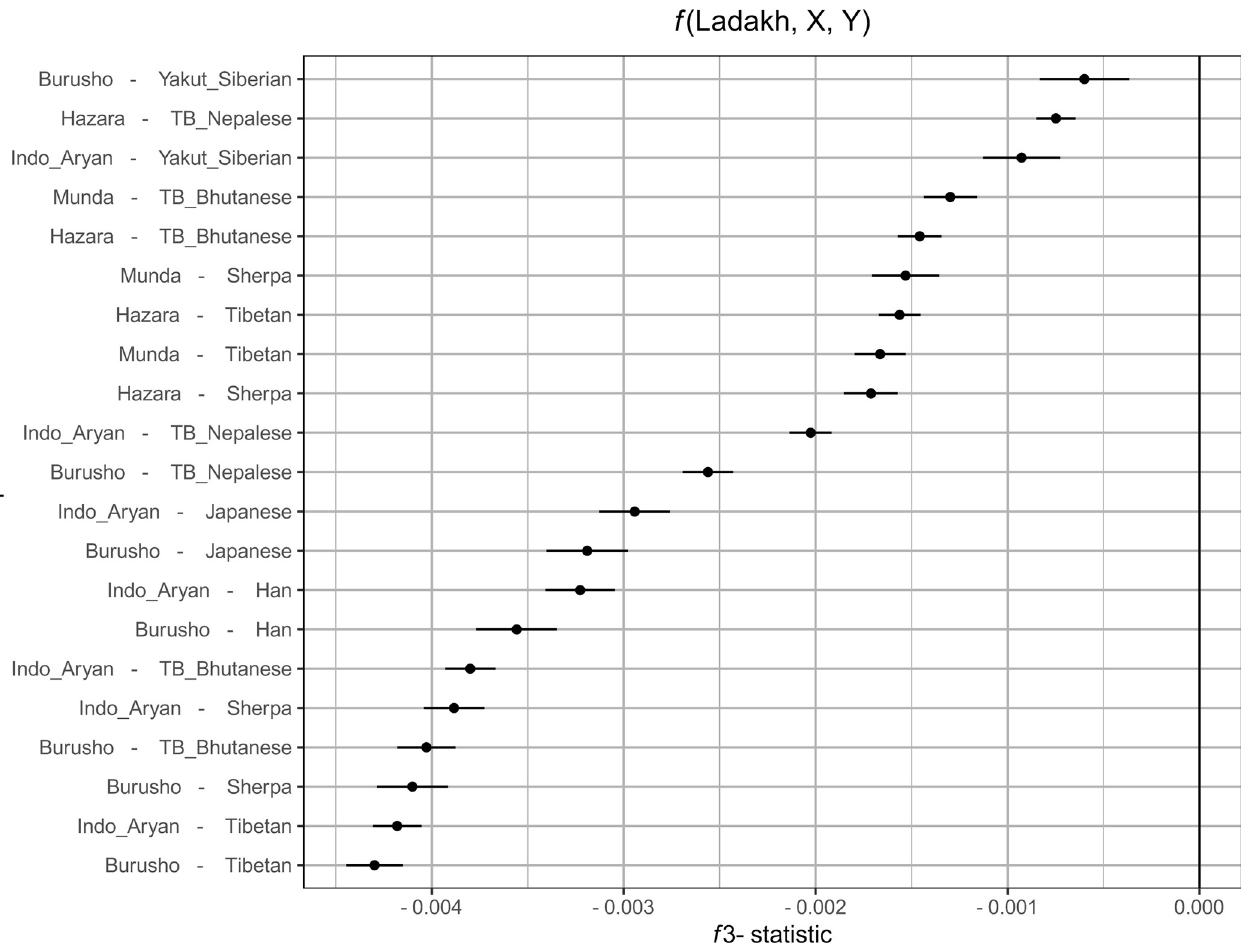
Fig 3. Evidence of admixture in Ladakhi between lowland or Indo-Aryan populations and highland or north/east Asian populations measured using f3 outgroup statistics. Along the x axis is the f3 statistic score. The more negative that statistic is, the greater is evidence of admixture. The error bars correspond to three standard errors of the estimated f3 statistic. Along the y axis are different pairs of putative source populations for an admixture event which creates the modern Ladakhi population.